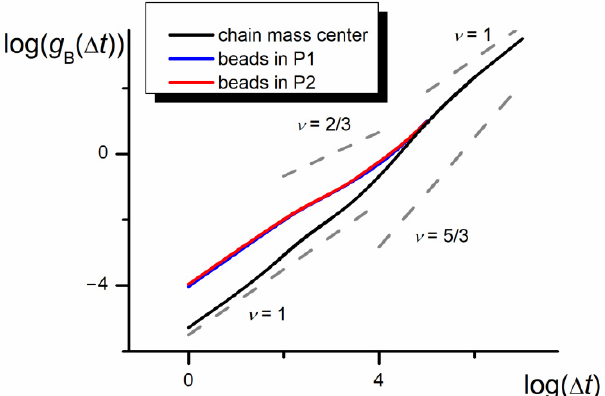
Figure 5. The log–log plot of the bead autocorrelation function, g B , and the chain autocorrelation function, g, in the nanochannel ( D = 3 b , N = 100, ε PP / k B T = 0, and − 1 for P1 and P2, respectively). The slopes of diffusion, subdiffusion, and quasi-ballistic modes (equal 1, 2/3, and 5/3) are marked in gray.